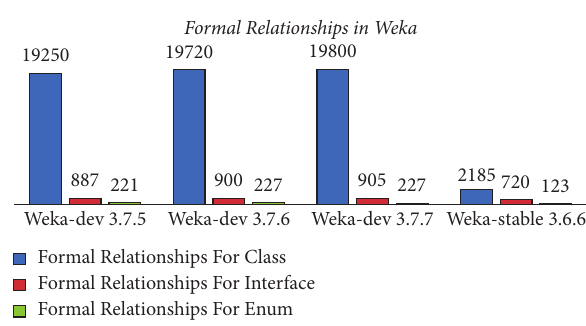
Figure 21: Count of formal relationships in weka.